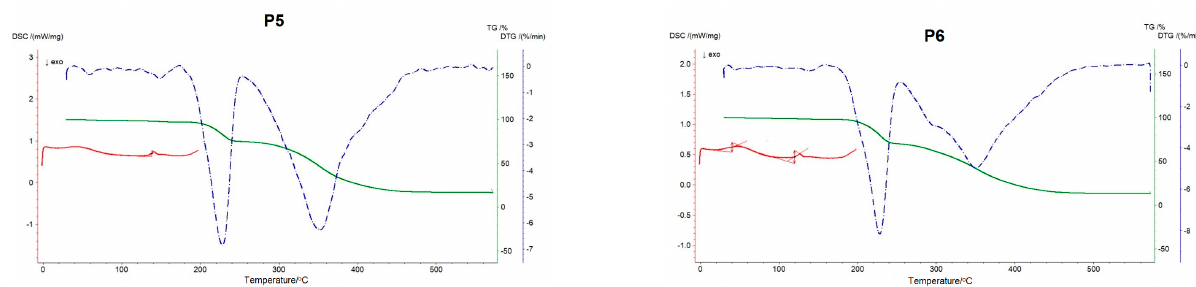
Figure 2. TG/DTG and DSC curves of peptide P2, P4–P6: TG (–), DTG (–), DSC (–). Figure 2. TG /DTG and DSC curves of peptide P2, P4–P6: TG (–), DTG (–), DSC (–).